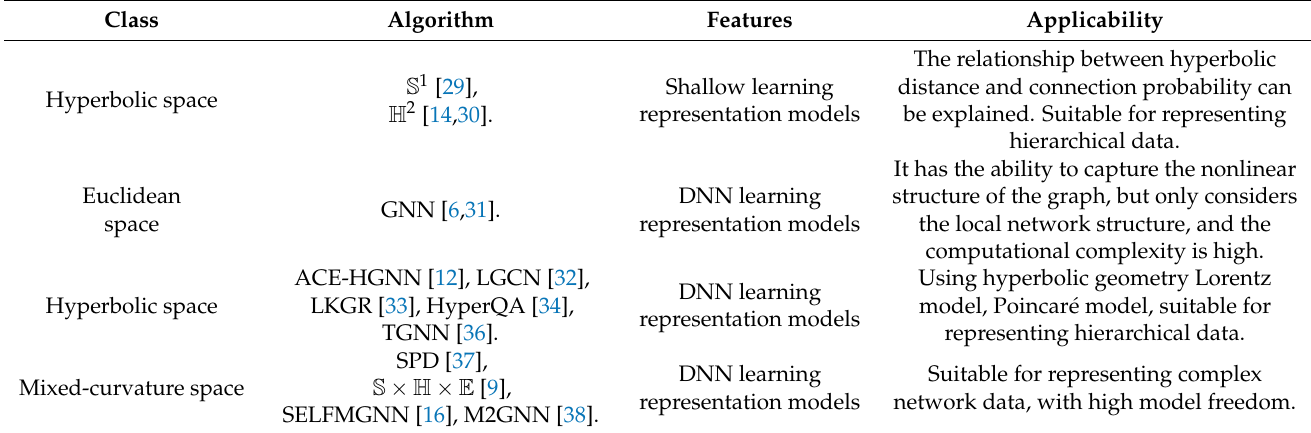
Table 1. Comparison of network representation learning methods.